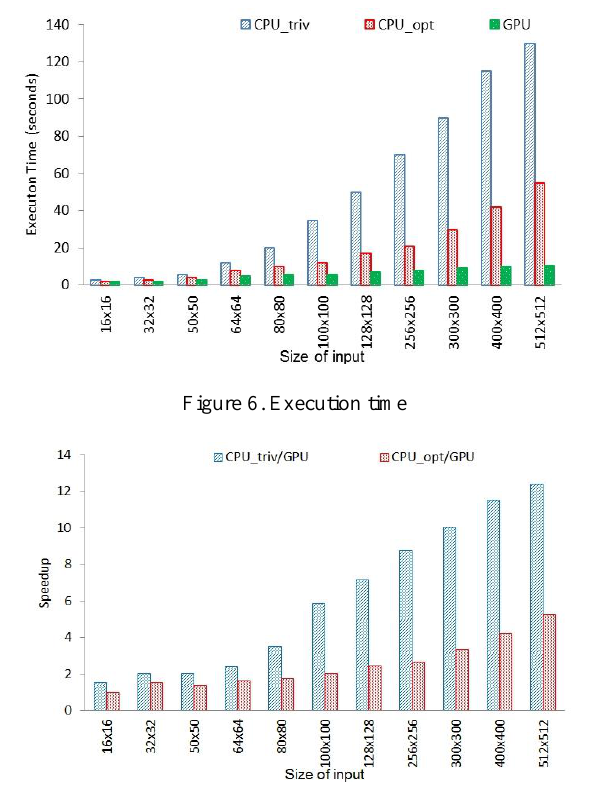
Figure 7. Speedup performance